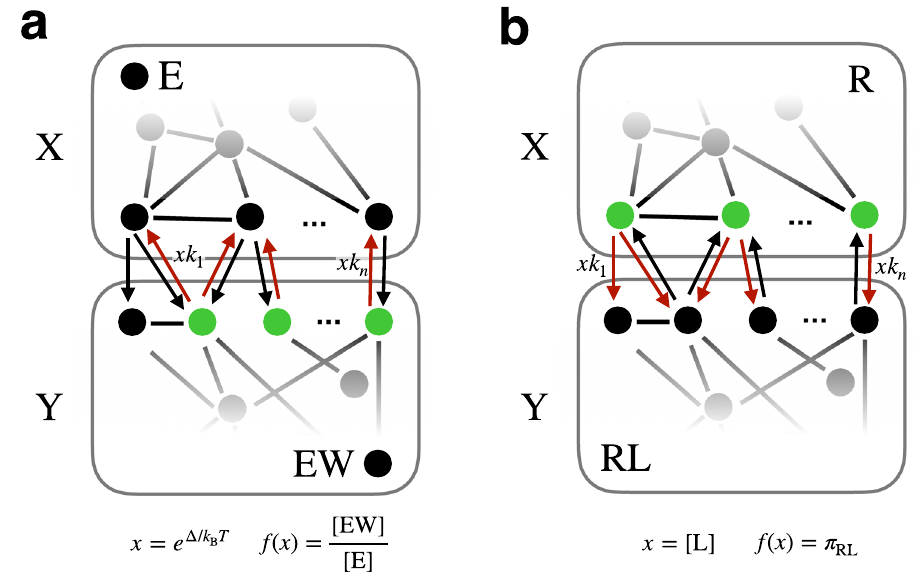
Fig. 2 | Common structure of proofreading and sensing models. a Murugan ’ s generalized proofreading scheme 6 , where the key assumption is that there is a “ discriminatory fence ” dividing the states into two halves, and every transition depending on the energy difference Δ crosses this fence. We are showing just half of a symmetric kinetic scheme — restricting attention to the part of the graph